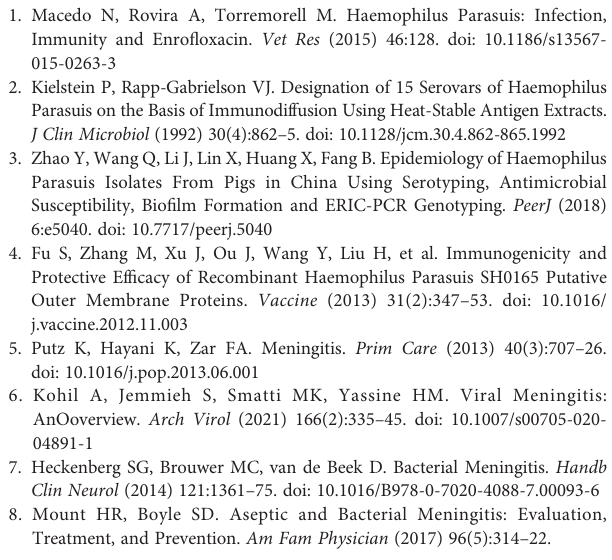
Supplementary Figure 1 | Hierarchical clustering heatmaps of differentially methylated CpG sites considering genomic context. Hierarchical clustering heatmap of differentially methylated CpG sites in 3 ’ UTR (A) , 5 ’ UTR (B) , exon (C) , intergenic (D) , intron (E) , promoter-TSS (F) , TTS (G) . Each row represents a methylated CpG site, H1, H2, H3 represent G. parasuis -infected porcine brain, and C1, C2, C3 represent negative controls. Supplementary Figure 2 | Volcano plot showing differentially methylated CpGs at different DNA methylation difference thresholds. The vertical axis shows the -log10 (p-value), and the horizontal axis shows DNA methylation difference. Blue dots shows the hypo-methylated CpGs when DNA methylation difference threshold is 0.1, red dots shows the hyper-methylated CpGs when DNA methylation difference threshold is